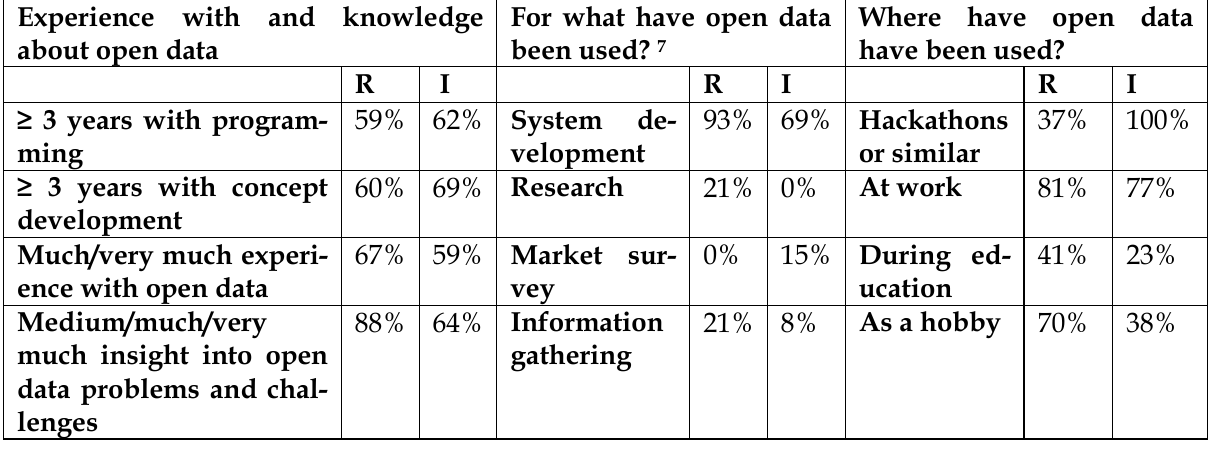
Table 2 Use of open data among questionnaire respondents (R) and interviewees (I) Experience with